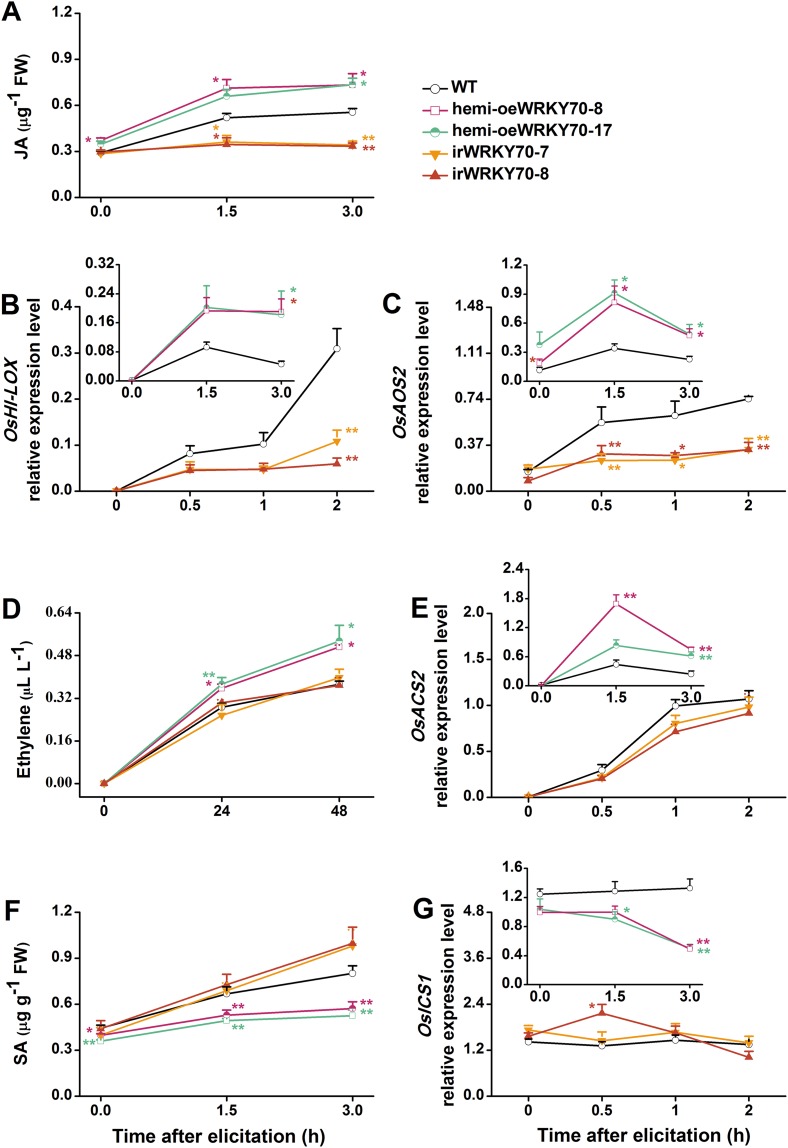
OsWRKY70 mediates SSB-elicited JA, SA, and ET accumulation.Mean levels (+SE, n = 5–10) of JA (A), ET (D), and SA (F), and mean expression levels (+SE, n = 5) of OsHI-LOX (B), OsAOS2 (C), OsACS2 (E), and OsICS1 (G) in irWRKY70, hemi-oeWRKY70, and WT plants that were individually infested by a third-instar SSB larva. Asterisks indicate significant differences in irWRKY70, hemi-oeWRKY70 compared with WT plants (*, p < 0.05; **, p < 0.01; Duncan's multiple range test).